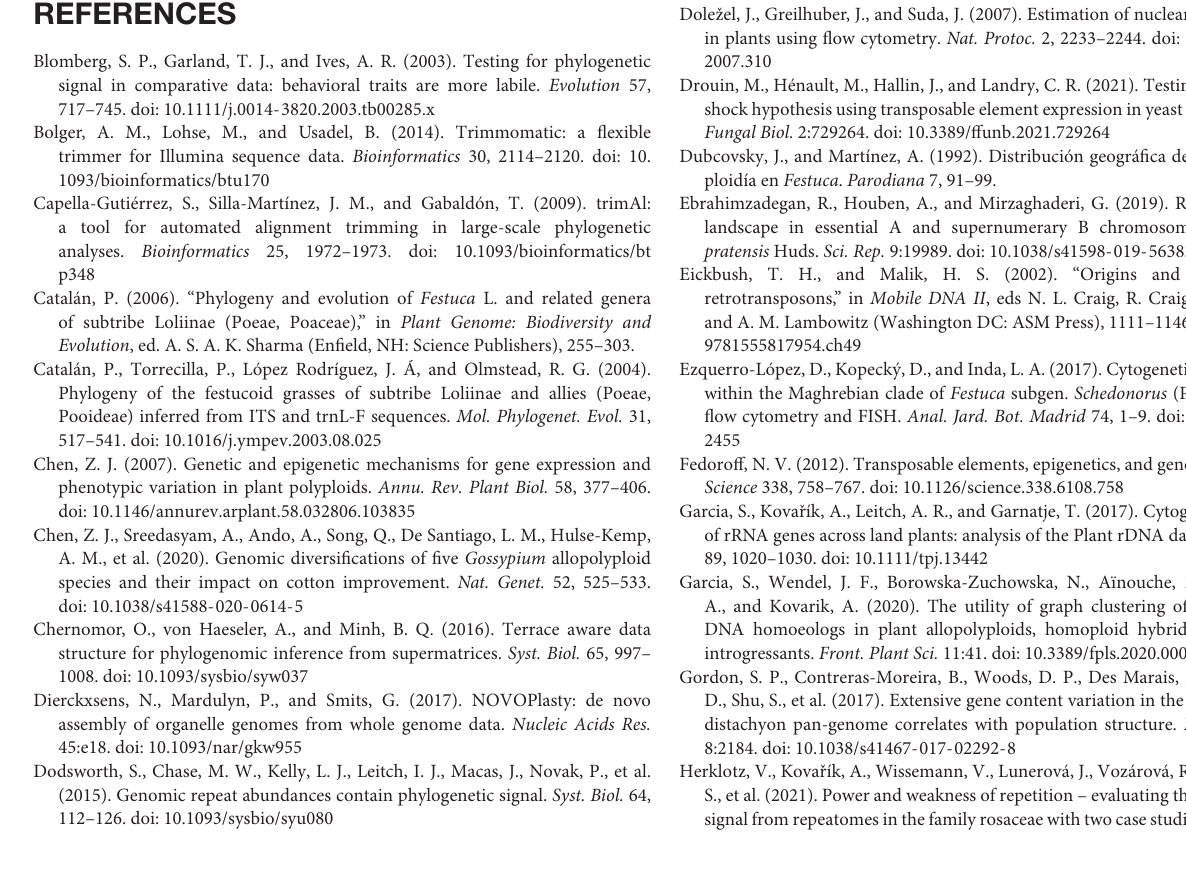
Supplementary Table 4 | Repeat Explorer 2 comparative analysis. Repeat content data for phylogenetically analyzed clusters (repeat families) in each of the four evolutionary groups of Loliinae: (A) Loliinae; (B) broad-leaved (BL) Loliinae; (C) fine-leaved (FL) Loliinae; (D) Schedonorus. Supplementary Table 5 | Phylogenetic signal based on Blomberg’s K values of repeat cluster contents obtained from the comparative RE2 analysis of Loliinae samples assessed in each of the four Loliinae groups: (A) Loliinae (38 samples, 38 clusters), (B) Broad-leaved (BL) Loliinae (15 samples, 96 clusters), (C) fine-leaved (FL) Loliinae (17 samples, 122 clusters), (D) Schedonorus (16 samples, 167 clusters), using the phylosig option of the phytools R package. Cluster abundance values (number of PE reads) are indicated in Supplementary Table 4 . K values close to one indicate phylogenetic signal, values close to zero phylogenetic independence, and values > 1 more phylogenetic signal than expected. p -Values based on 1000 randomizations. Significant values are highlighted in bold. Supplementary Figure 1 | (A) Combined (plastome + 35S rDNA) Loliinae coalescent species tree computed through Singular Value Decomposition quartets (SVDq) analysis showing bootstrap support values on branches. (B–D) Maximum Likelihood phylogenomic trees of 47 Loliinae samples based on (B) Combined (plastome + 35S rDNA) data, (C) plastome data, (D) nuclear 35S rDNA data, (E) Histograms of repeat contents per holoploid genome (1C) retrieved from the individual Repeat Explorer 2 analyses of the studied Loliinae samples mapped onto the Maximum Likelihood combined phylogenomic tree (plastome + nuclear 35S rDNA cistron) of Loliinae. Ultrafast bootstrap support values are indicated on branches. Oryza sativa and Brachypodium distachyon outgroups were used to root the trees. Color codes of Loliinae lineages are indicated in the charts. Scale bar: number of mutations per site.